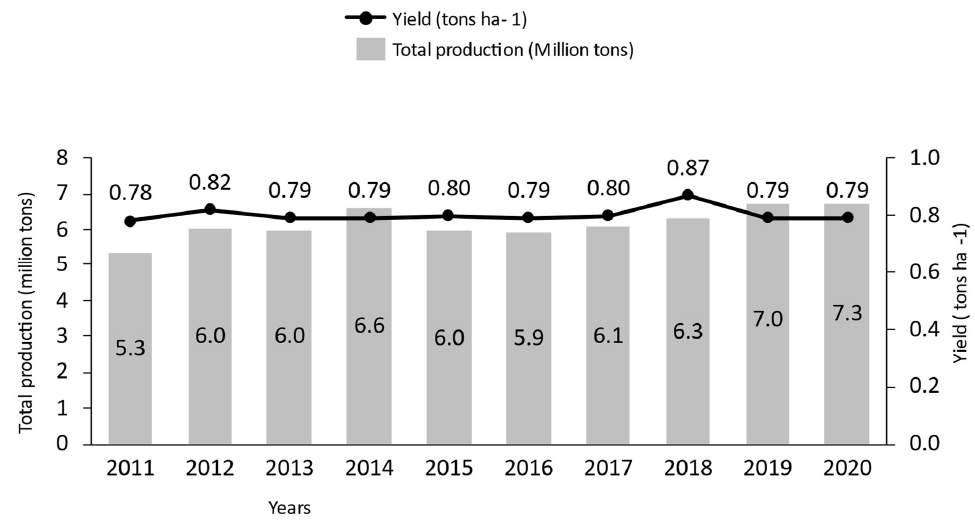
Figure 1. Total sesame production (million tons) and seed yield (tons ha −1 ) from 2011 to 2020 globally (adapted from FAOSTAT